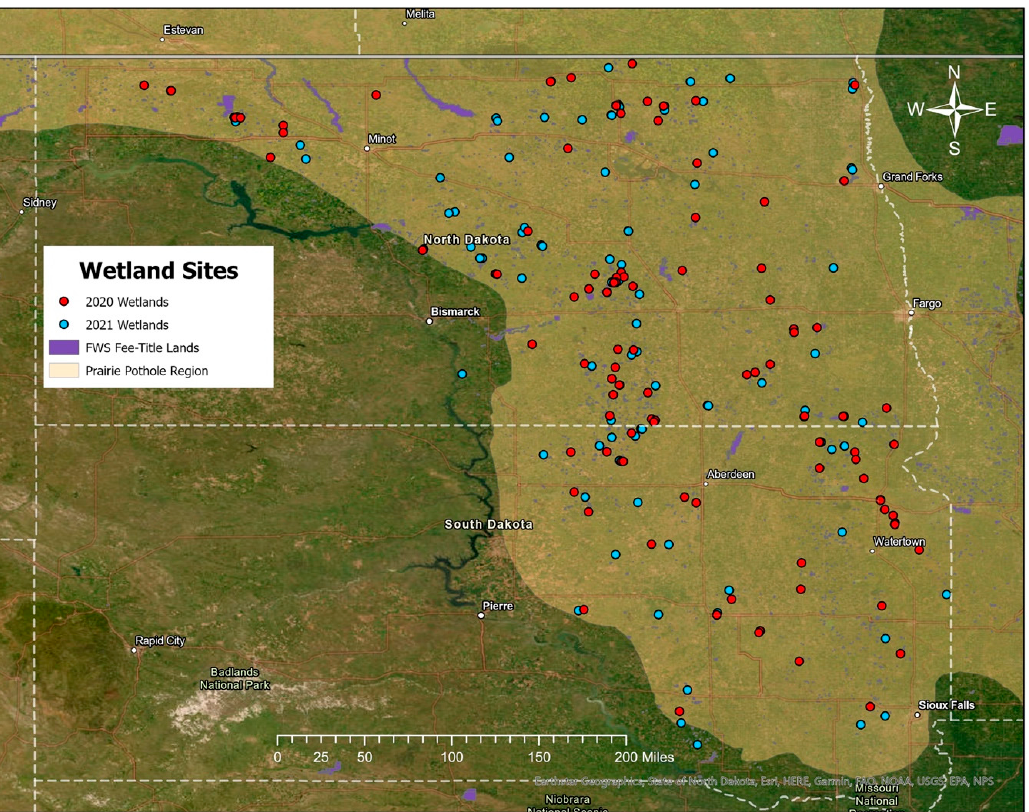
Figure 3. Distribution of the 200 temporary and seasonal wetlands sampled, with the southern Prairie Pothole Region and North Dakota and South Dakota outlined. Sites visited in 2020 are shown in red, and sites visited in 2021 are shown in blue.